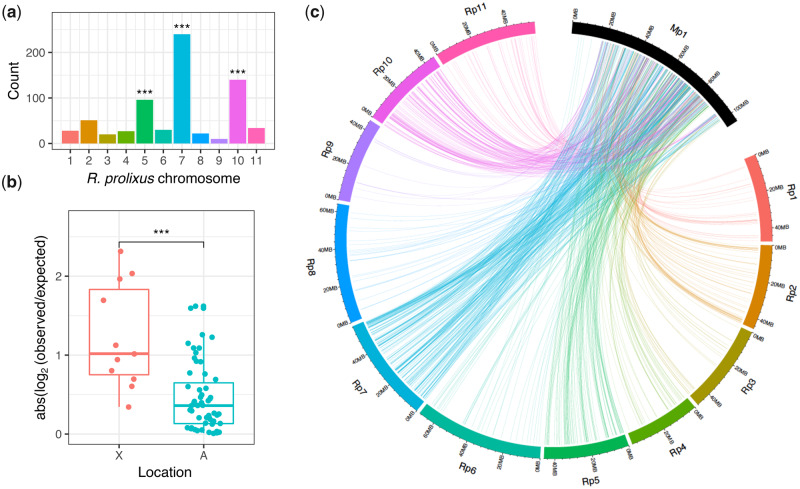
Ortholog mapping between the aphid Myzus persicae and the kissing bug Rhodnius prolixus. (a) Counts of Rhod. prolixus chromosomal location for 698 M. persicae–Rhod. prolixus 1:1 orthologs located on the M. persicae X chromosome (scaffold_1). Stars above bars indicate significant enrichment of a specific Rhod. prolixus chromosome after correcting for multiple testing (binomial test: BH corrected P < 0.05). (b) Absolute odds ratios (log2[observed/expected]) for Rhod. prolixus chromosomal enrichment on the M. persicae X chromosome and M. persicae autosomes. Each dot shows the odds ratio for a specific Rhod. prolixus chromosome. ***Wilcoxon rank-sum test W = 517, P = 2.31 × 10−4. (c) Chord diagram showing links between the M. persicae X chromosome (shown as Mp1) and the Rhod. prolixus chromosomes for 1:1 orthologs. Rp10 is the Rhod. prolixus X chromosome, the Rhod. prolixus Y chromosome is not assembled.